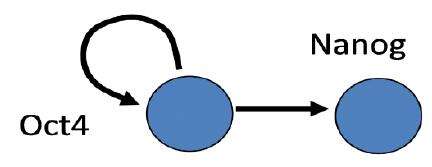
Figure 2: Example of TF regulatory events defined by ChIP-seq data (gene targeting by TF binding in promoter